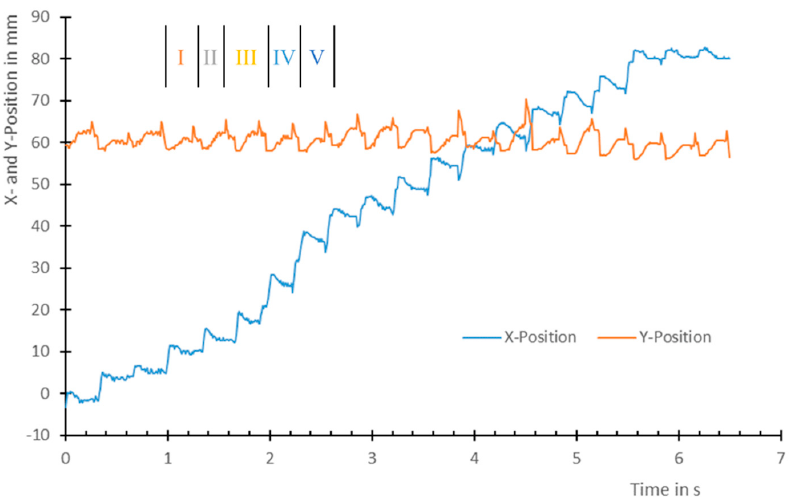
Figure 6. Movement of the scraping tool during scraping. Roman numerals refer to individual scraping cycles in Figure 7.